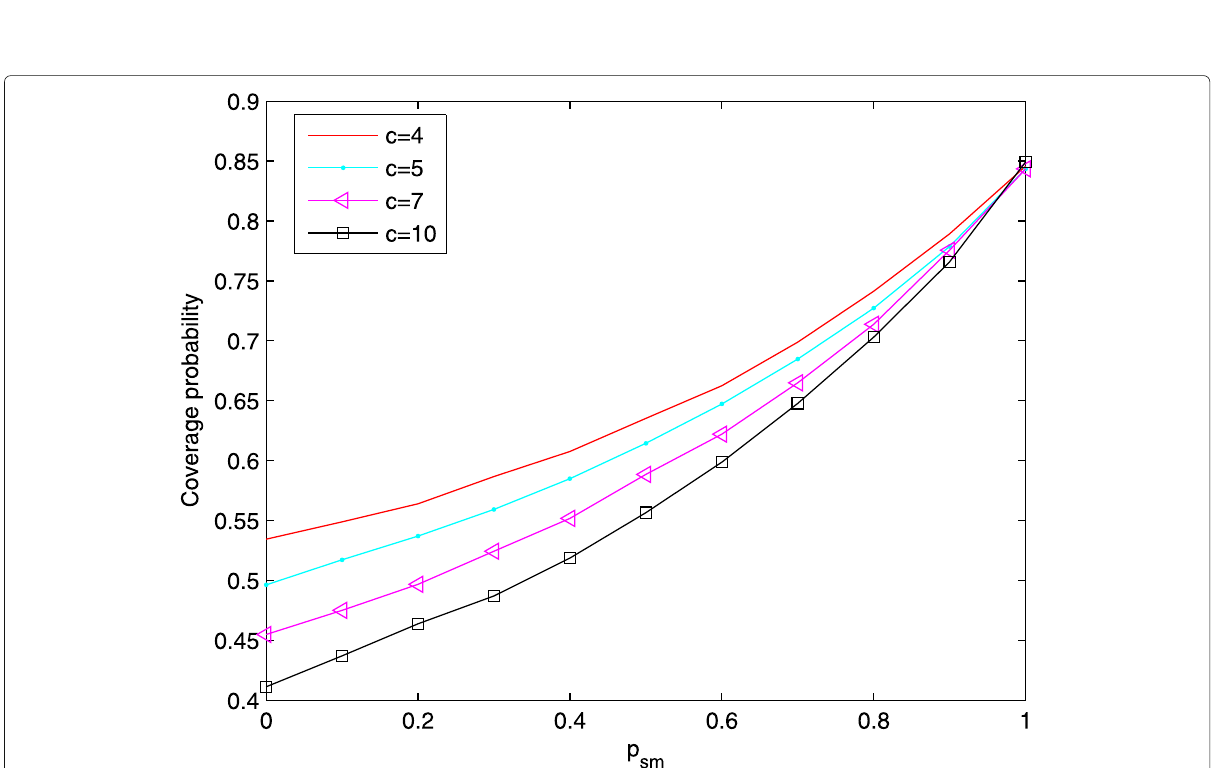
Fig. 6 Coverage probability vs. the mmWave probability p